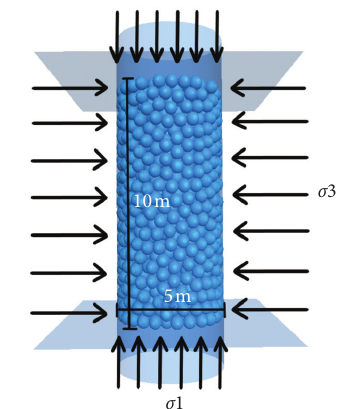
Figure 5: Schematic diagram of the numerical three-axis loading